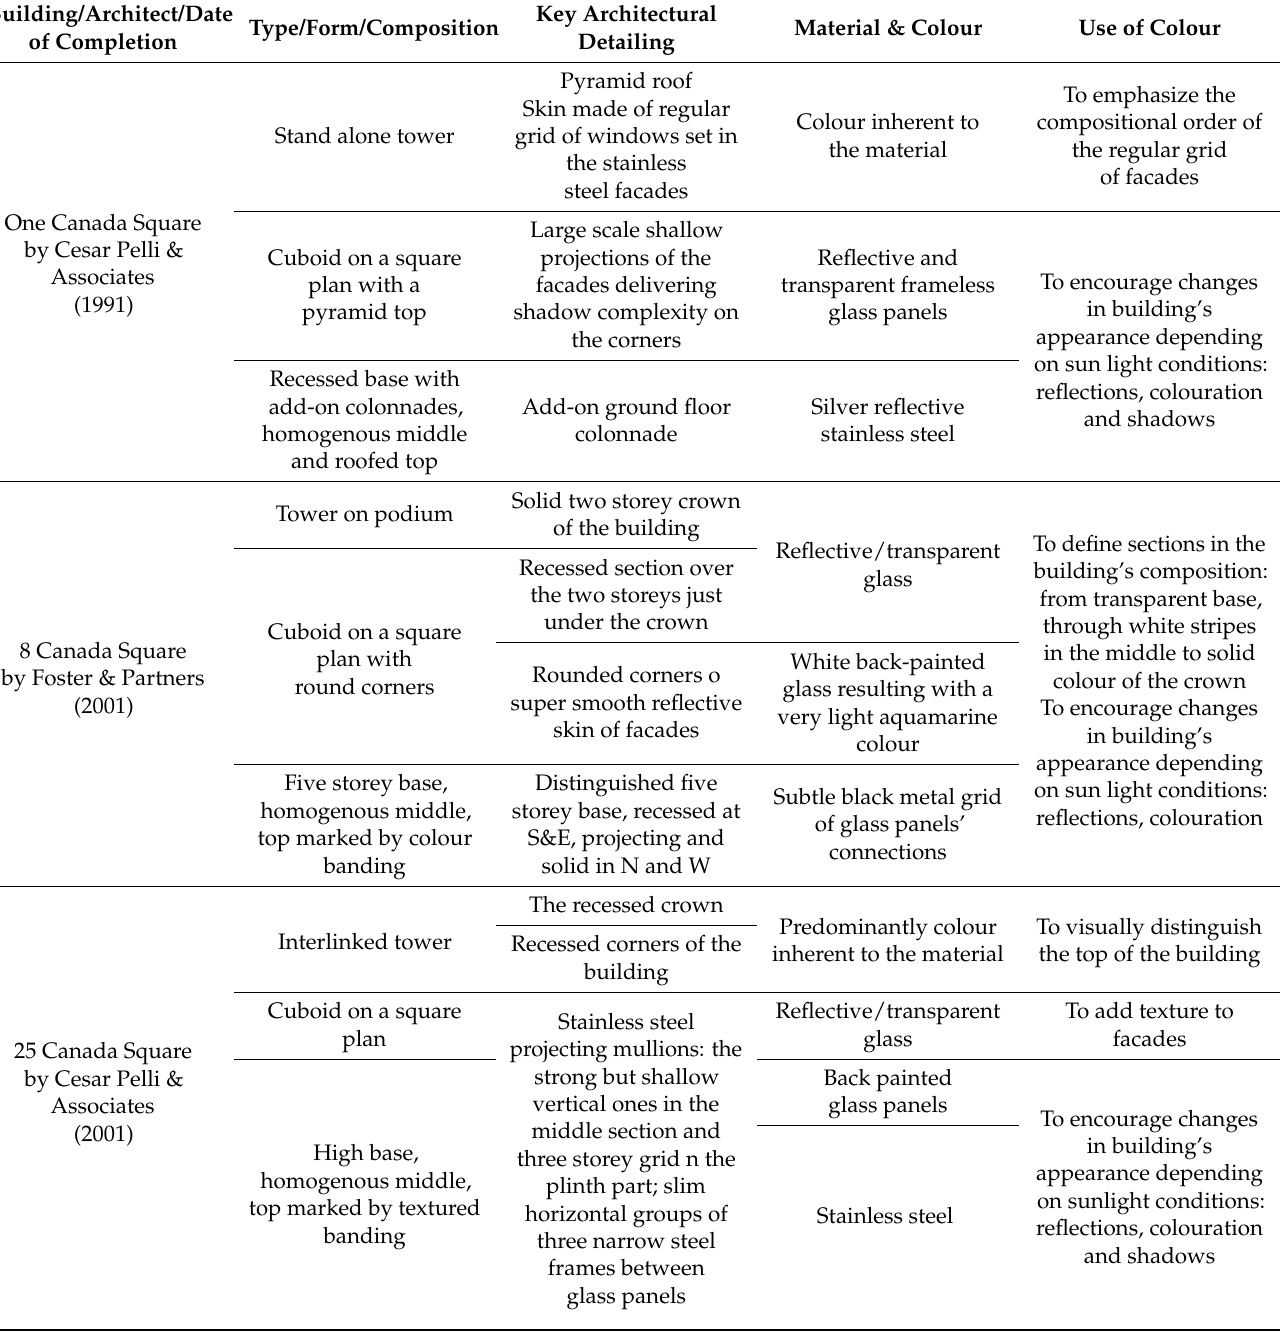
Table A1. Use of colour in tall office buildings from the first phase of the regeneration on the Isle of